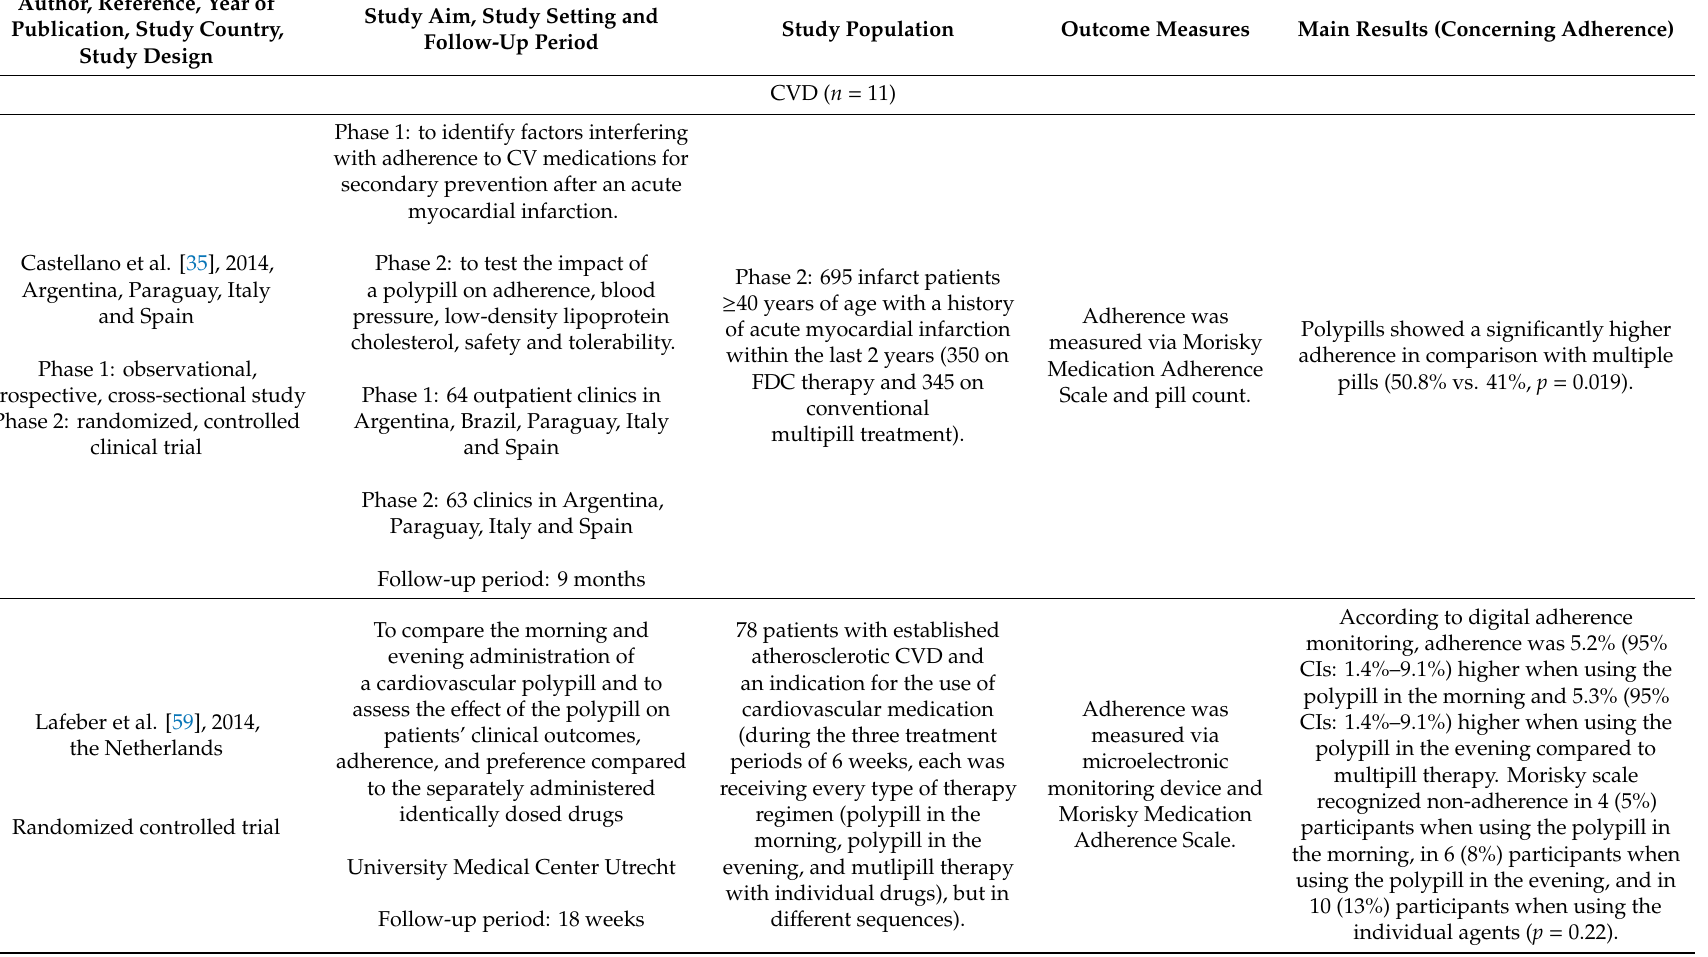
Table A2. Summary of the original articles ( n = 67) regarding aim, study setting, follow-up period, population, type of adherence outcome measures, and